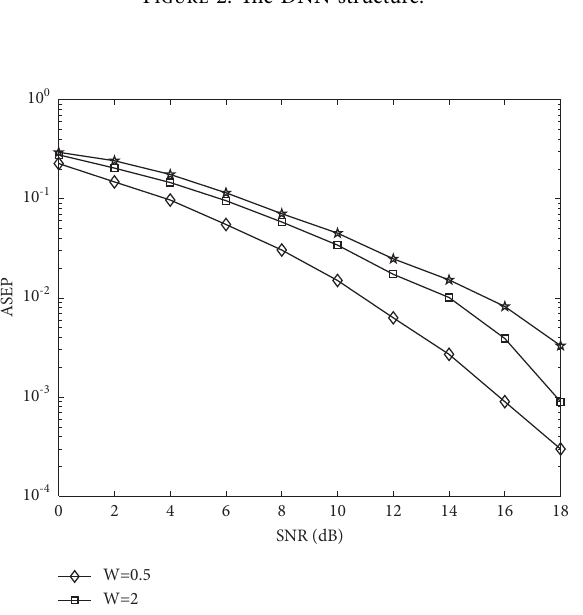
Figure 2: The DNN structure.